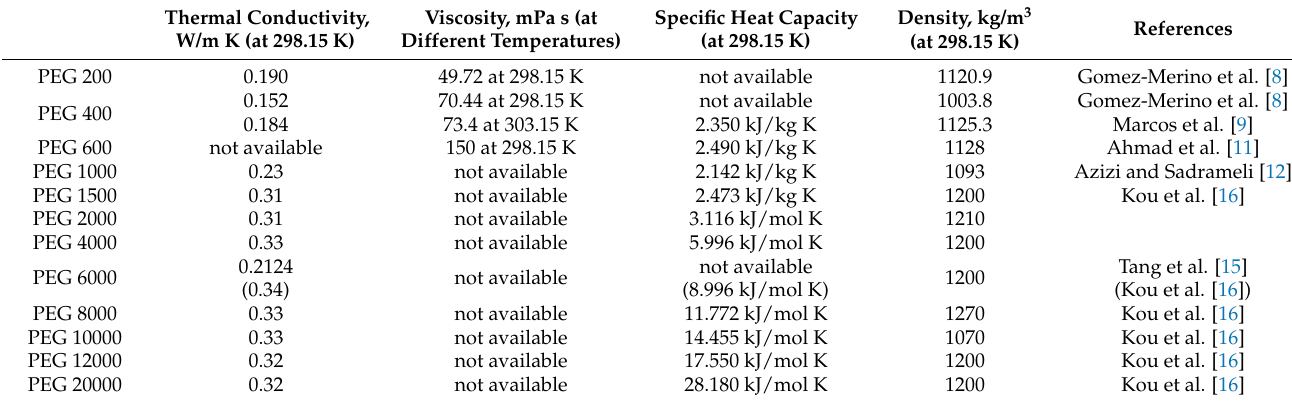
Table 2. Thermophysical properties of several forms of PEG, as identified in the literature. Thermal Conductivity, W/m K (at 298.15